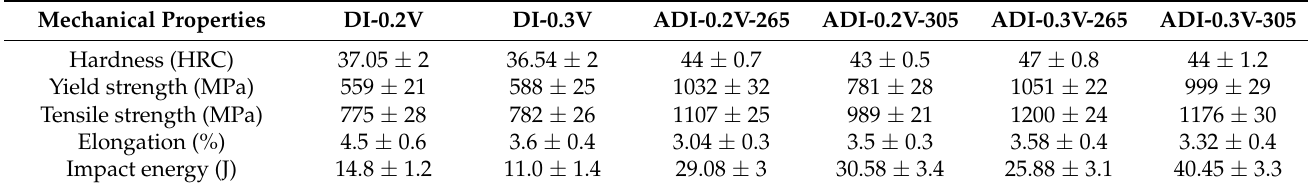
Table 5. Mechanical properties of the ADI camshafts low alloyed with 0.2 and 0.3 wt.%